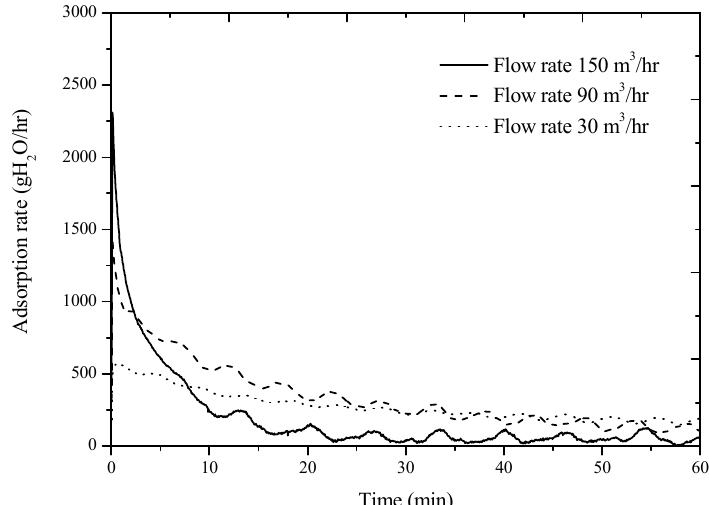
Figure 7. The variation of adsorption rate with time at an ambient temperature of 25 °C and relative humidity of air of 85%, at various airflow rates.